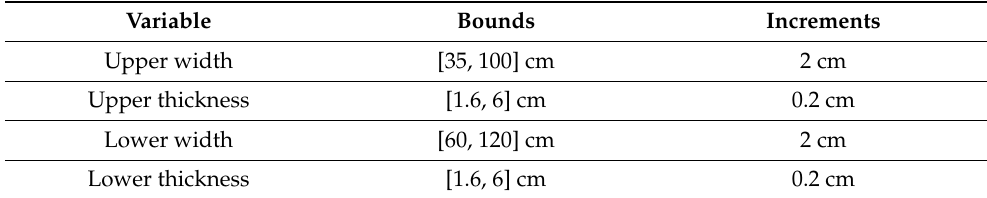
Table 5. Design variables and boundaries.